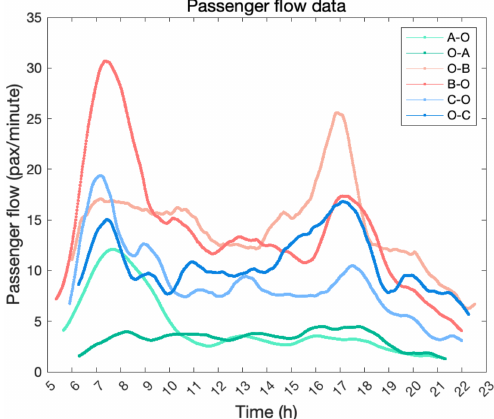
Figure 9. Passenger flow data of different lines.